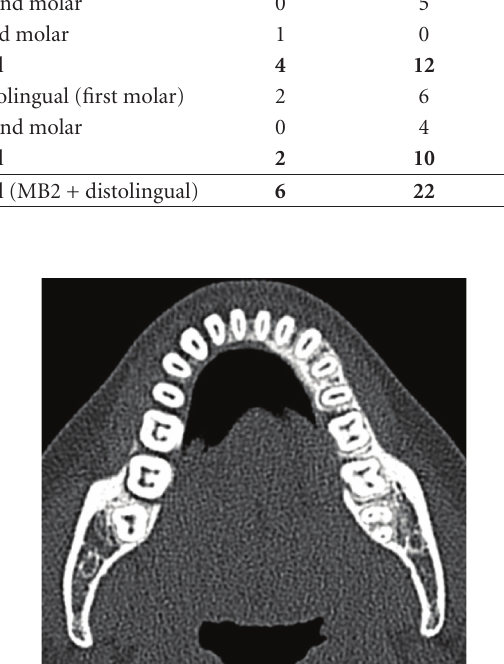
Figure 3: Axial view showing four canals in right first and second mandibular molars.